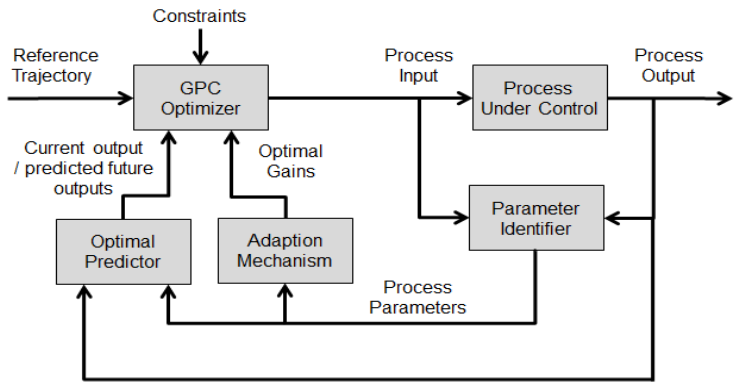
Figure 1. Adaptive model predictive control (MPC) Control Structure.